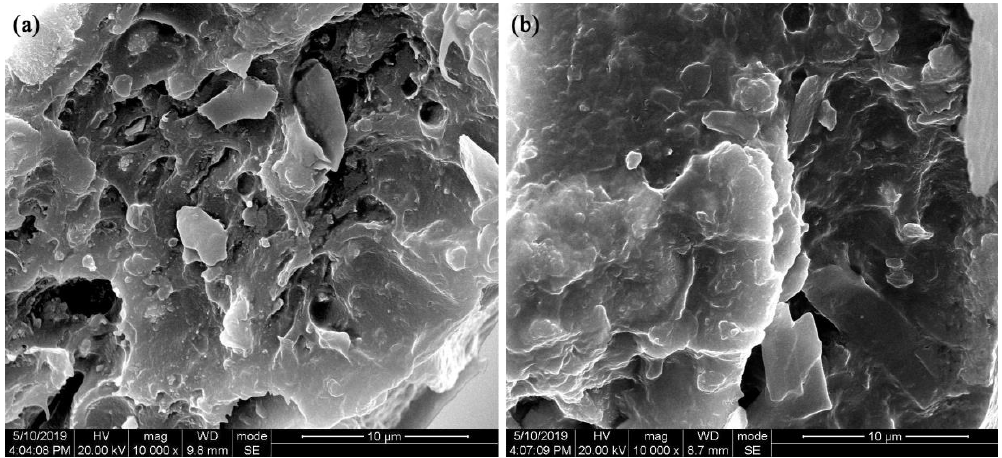
Figure 12. SEM images of the BT@ZnPc-GO-1/PEN films with 15 wt % BT@ZnPc-GO-1 nanoparticles ( a ) before and ( b ) after isothermaol annealing at 280 °C for 2 h.